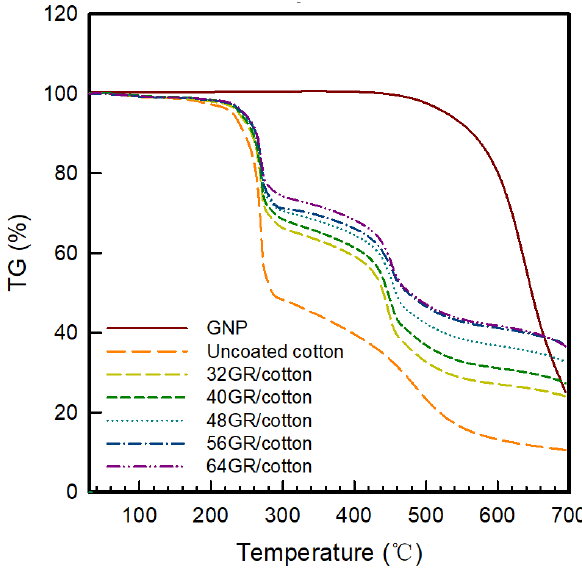
Figure 4. Thermogravimetric analysis (TGA) curve of GR/cotton coated with various high-content of graphene nanoplatelets. Table 3. Thermal stability properties of GR/cotton coated with various high-content of graphene nanoplatelets.